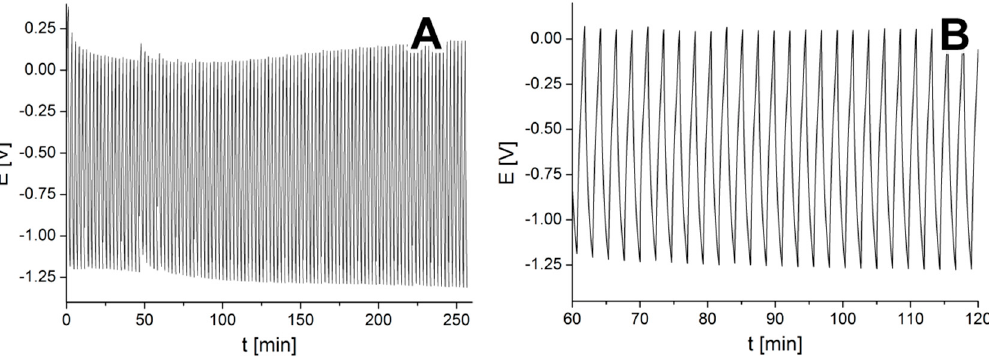
Figure 5. Potential versus time plot for 260-min GCD experiment ( A ) and detailed view of 25 cycles ( B ) registered for G-BN7 at the current density of 1A/g in 3M of KOH.